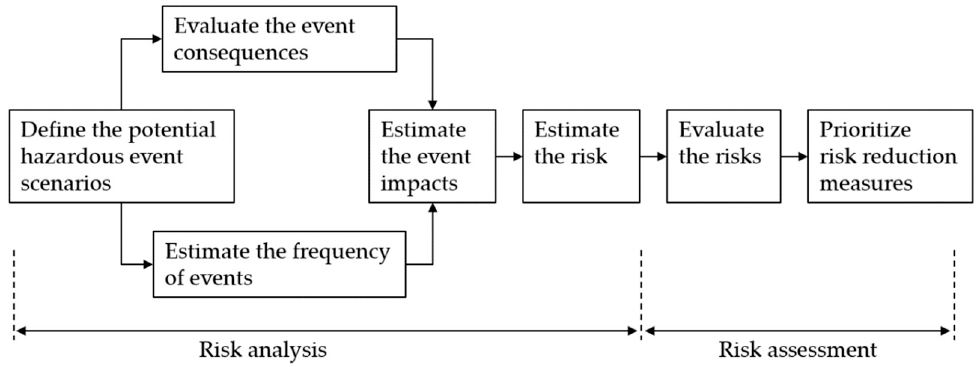
Figure 5. The steps of QRA, modified from chemical process QRA (adapted from [12]).